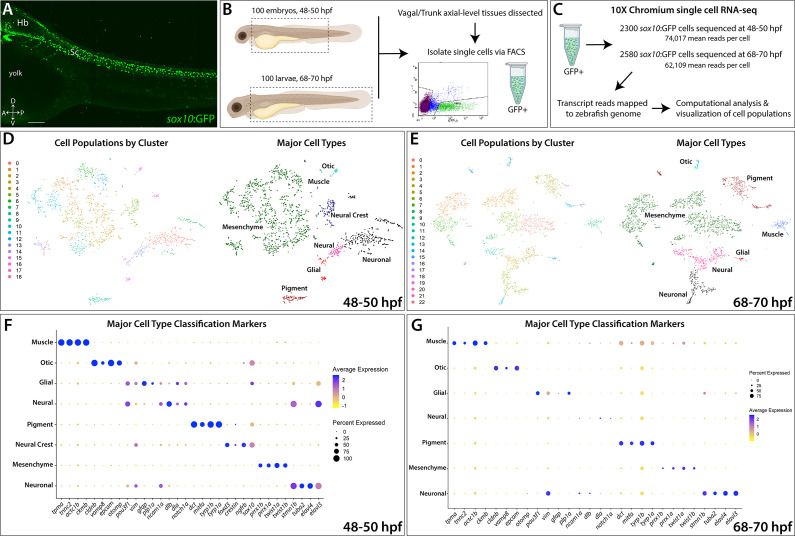
Single-cell profiling strategy and cell population composition of posterior sox10:GFP+ cells from the posterior zebrafish during the embryonic to larval stage transition.(A) Confocal image of a sox10:GFP+ embryo at 48 hpf; Hb: Hindbrain; Sc: Spinal cord. A: Anterior, P: Posterior, D: Dorsal, V: Ventral. Scale bar: 50 μM (B) Cartoon illustrations of a zebrafish embryo at 48–50 hpf and an early larval fish at 68–70 hpf depicted laterally to summarize the dissection workflow used to collect posterior sox10:GFP+ cells. (C) Schematic of the 10X Genomics Chromium and data analysis pipeline. (D) tSNE plots showing the arrangement of Clusters 0–18 and where the major cell types identified among sox10:GFP+ cells arrange in the 48–50 hpf dataset. (E) tSNE plots showing the arrangement of Clusters 0–22 and where the major cell types identified among sox10:GFP+ cells arrange in the 68–70 hpf dataset. (F,G) Dot plots of the identifying gene markers for each major cell type classification in the 48–50 hpf and 68–70 hpf datasets, respectively. Dot size depicts the cell percentage for each marker within the dataset and the color summarizes the average expression levels for each gene.Figure 1—source data 1.List of marker genes per cluster in the sox10:GFP scRNA-seq datasets.Tables reporting the Seurat output for genes for each cluster at the 48–50 hpf (Tab 1) and 68–70 hpf (Tab 2) time points, including p-values (<0.01), average log-fold change (≥0.25), adjusted p-values (≤1.0), pct.1 summarizing proportion of cells expressing the individual gene in the cluster, pct.2 showing the proportion of cells expressing the individual gene in all other clusters in the dataset.Figure 1—source data 2.Table summarizing the top identity markers used for major cell type and subtype cellular classifications for each cluster at 48–50 and 68–70 hpf.References cited: Barske et al., 2016; Carney et al., 2006; Ding et al., 2013; Du et al., 2003; Dutton et al., 2001; Farnsworth et al., 2020; Feregrino et al., 2019; Gaudet et al., 2011; Heanue and Pachnis, 2008; Knight et al., 2003; Lister et al., 1999; Ludwig et al., 2004; Lu et al., 2019; Luo et al., 2001; Minchin and Hughes, 2008; Nakamura et al., 2016; Nord et al., 2016; Parichy et al., 2000; Petratou et al., 2018; Petratou et al., 2019; Quigley and Parichy, 2002; Saunders et al., 2019; Shepherd et al., 2004; Soldatov et al., 2019; Sperber and Dawid, 2008; Sperber et al., 2008; Stewart et al., 2006; Taylor et al., 2016; Thisse et al., 2001; Thisse and Thisse, 2004; Thisse and Thisse, 2005; Uyttebroek et al., 2010; Yelon et al., 2000.